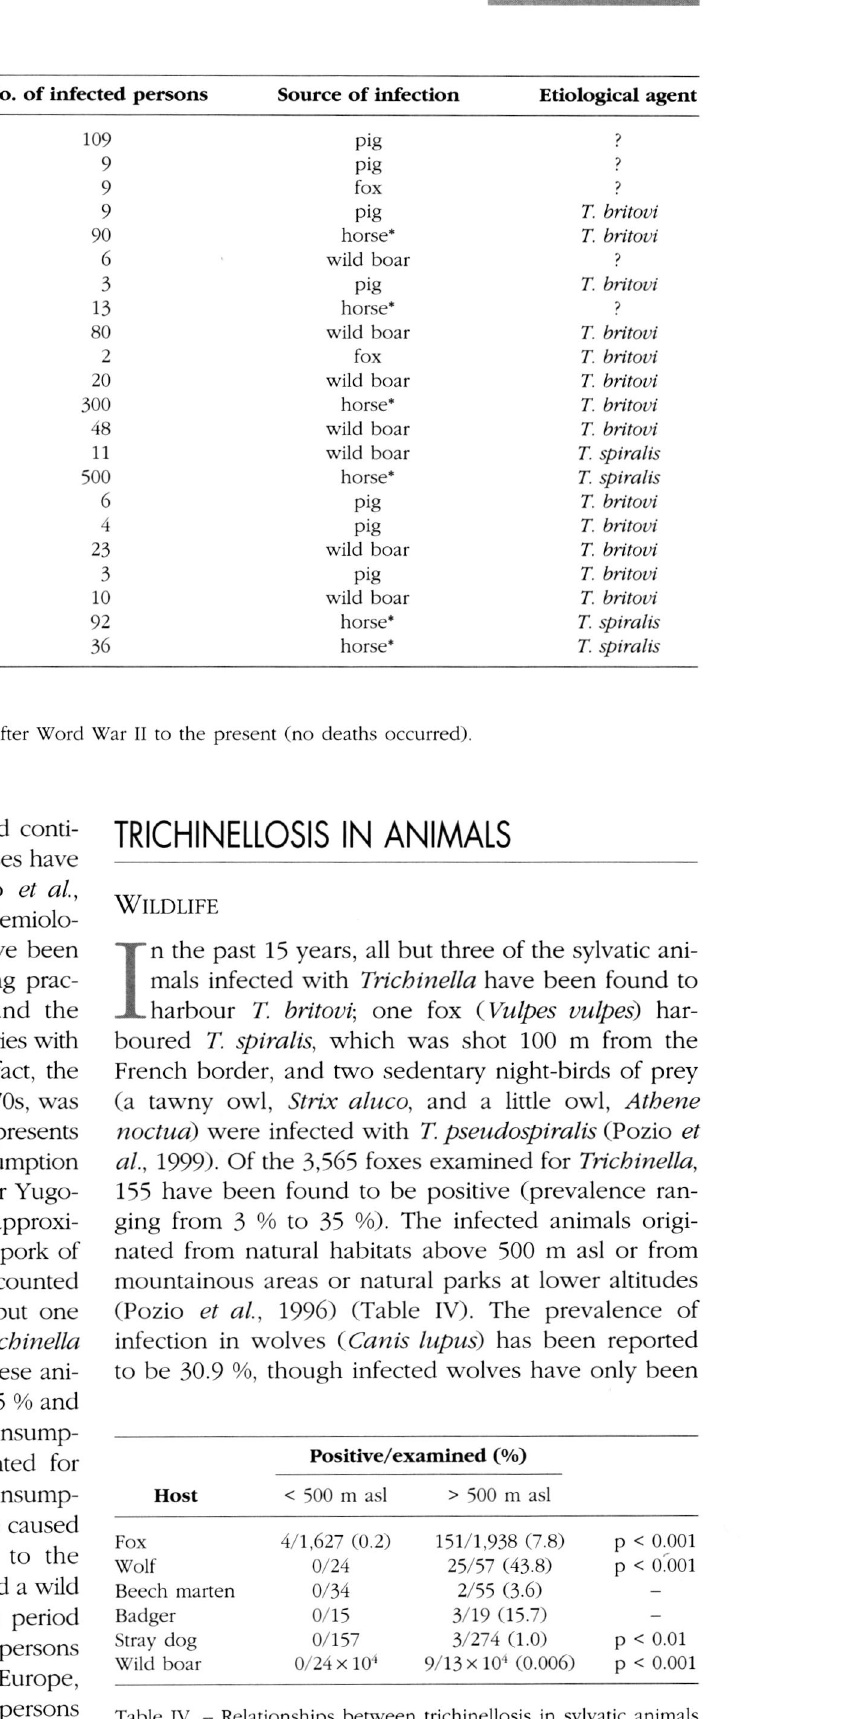
Table IV. - Relationships between trichinellosis in sylvatic animals and altitude (asl: above sea